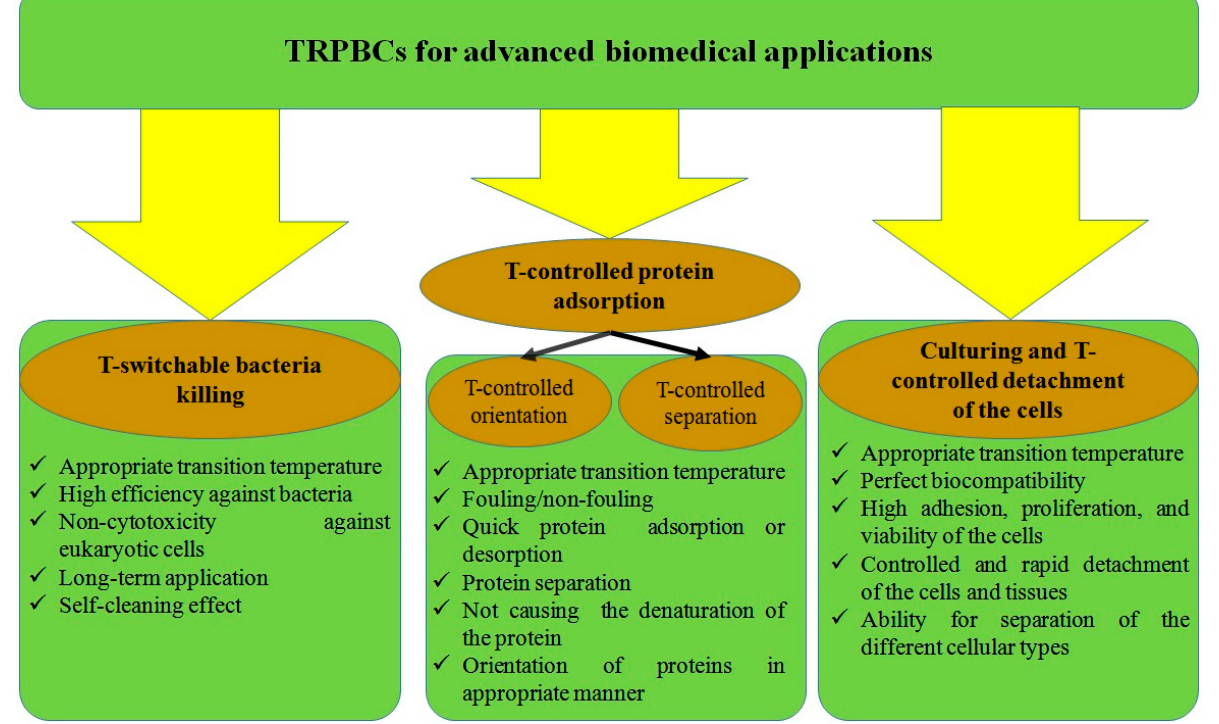
Figure 1. Advanced biomedical applications of the TRPBCs and the specific criteria required for these applications.